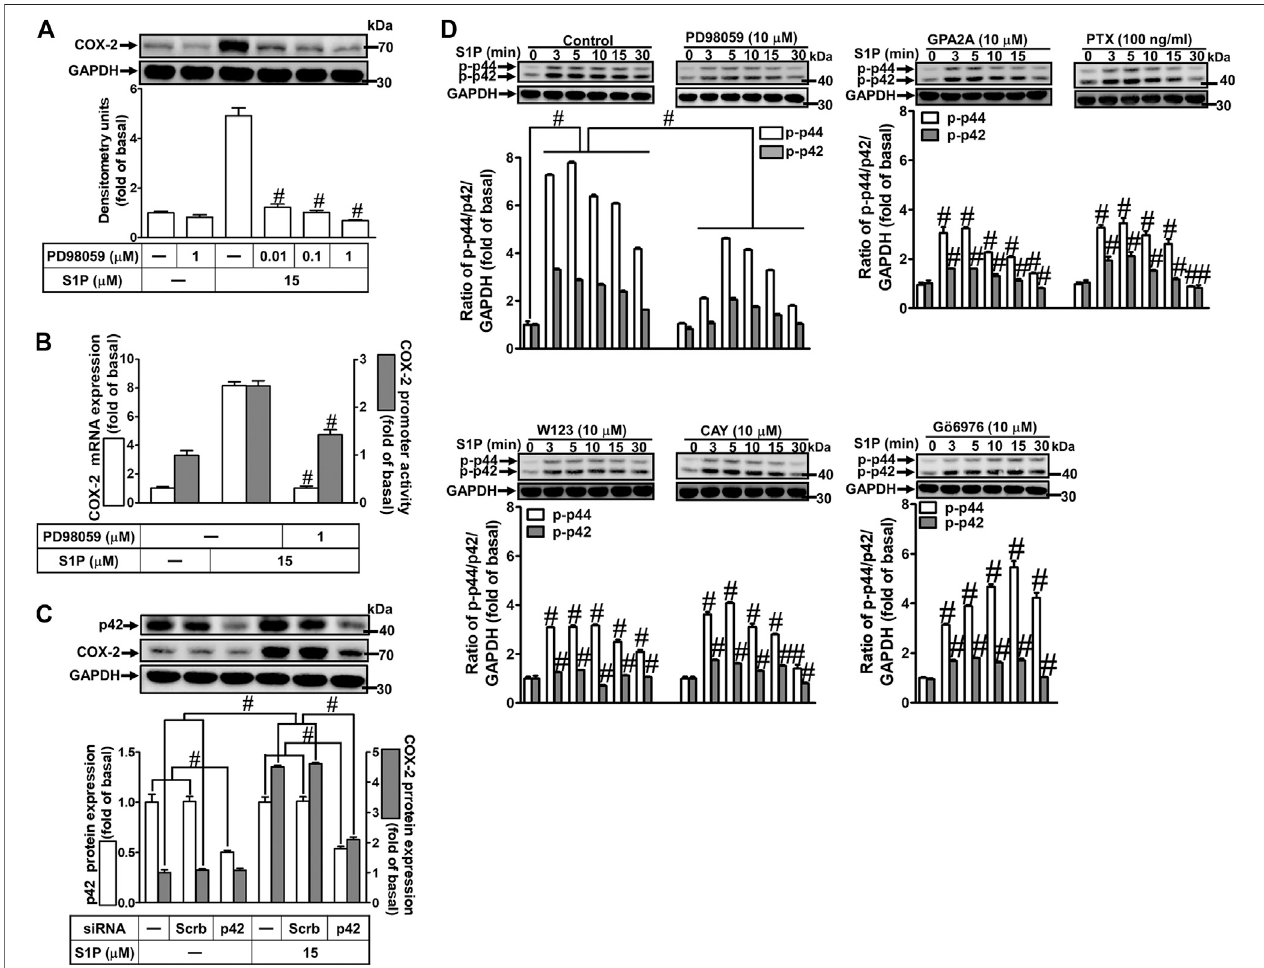
FIGURE 5 | S1P-induced COX-2 expression is mediated through p42/p44 MAPK phosphorylation. (A) Cells were pretreated with PD98059 for 1 h and then incubated with 15 μ M S1P for 8 h. (B) Cells were transfected without or with COX-2 promoter-luciferase reporter gene, pretreated without or with PD98059 (10 μ M) for 1 h, and then incubated with 15 μ M S1P for 4 h (mRNA) or 1 h (promoter). The levels of COX-2 protein, mRNA expression, and promoter activity were determined by Westernblot,realtime-PCR,andpromoterassay,respectively. (C) CellsweretransfectedwithsiRNAofscrambledorp42MAPKandthenexposedtoS1Pfor8 h. (D) CellswereincubatedwithS1P(15 μ M)fortheindicatedtimeintervalsintheabsenceorpresenceofPD98059(10 μ M),W123(10 μ M),CAY(10 μ M),GPA2A(10 μ M), PTX (100 ng/ml), or Gö6976 (10 μ M). The cell lysates were collected and analyzed by Western blot. The fold of basal was de fi ned as normalization of the data to the respective “ 0, ” and then compared the data of corresponding time points ofcontrol vs inhibitor with a statistic method, as described in the section of Methods . Data are expressed as mean ± SEM of three individual experiments (n (cid:2) 3). # p < 0.05, as compared with the cells treated with S1P